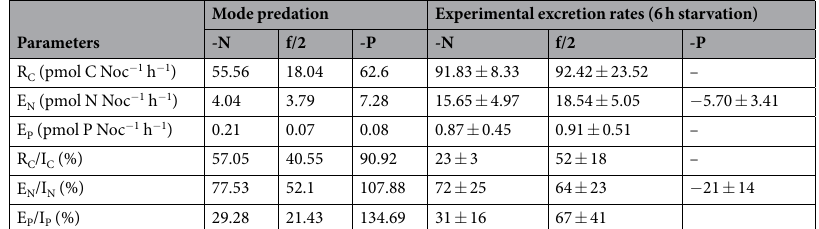
E P (pmol P Noc − 1 h − 1 )